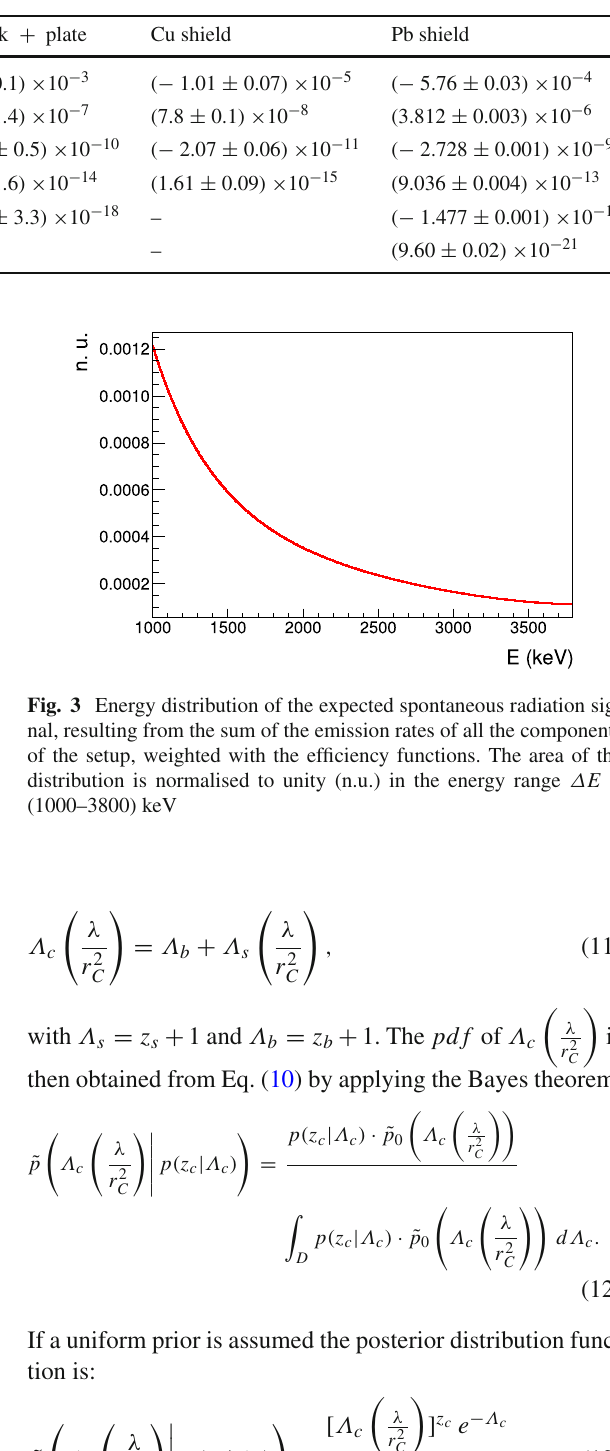
Table 1 The table summarises the parameters obtained from the best fit to the efficiency spectra, for each component of the setup which gives a significant contribution